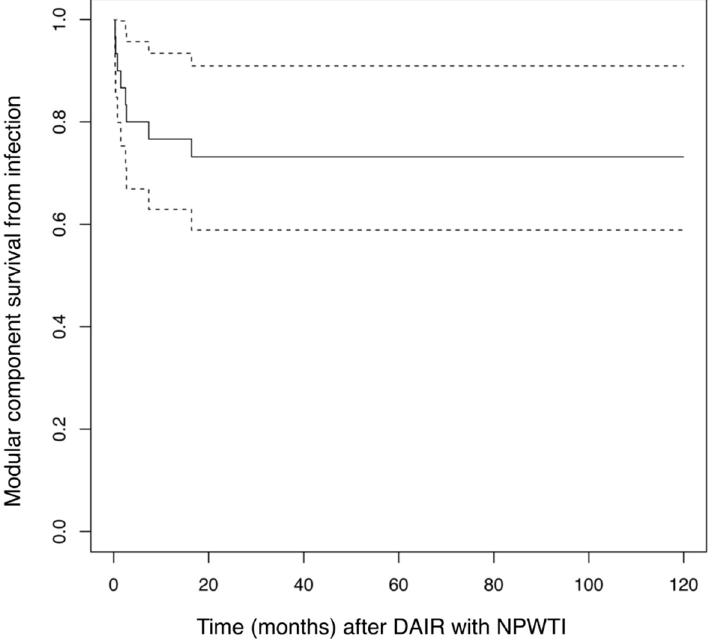
Figure 2. Kaplan–Maier curve showing infection-related implant survival after DAIR with NPWTI for an estimated 10 year follow up. The confidence intervals are represented by the dotted lines.